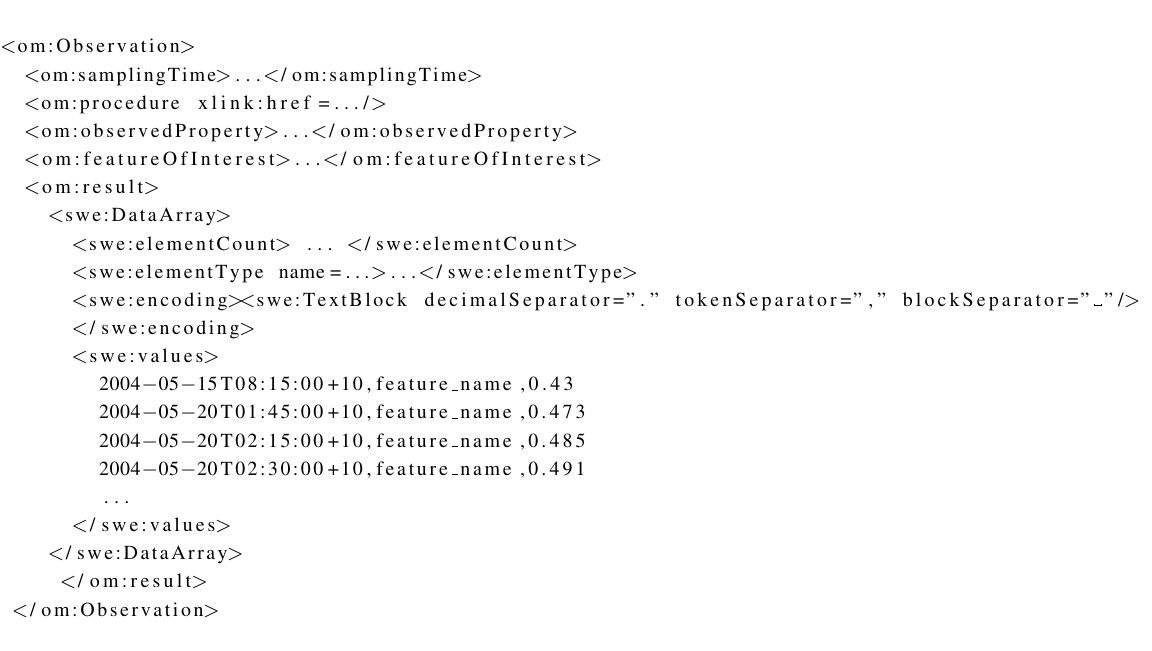
Figure 6. Observations encoded as a